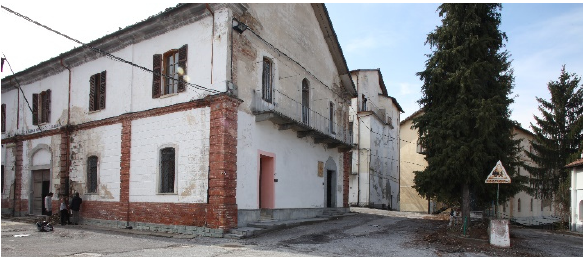
Figure 2. A view of a part of the Giuseppe Galliano Barrack in